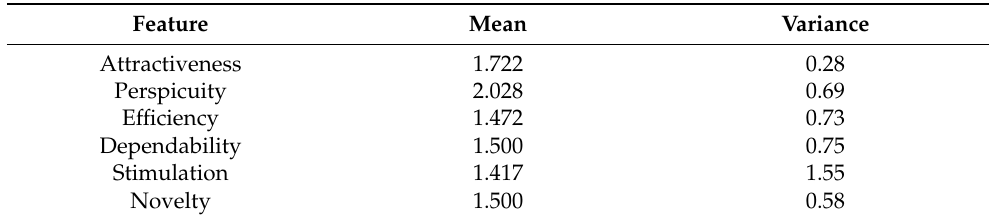
Table 3. First training course—UEQ scales (mean and variance).